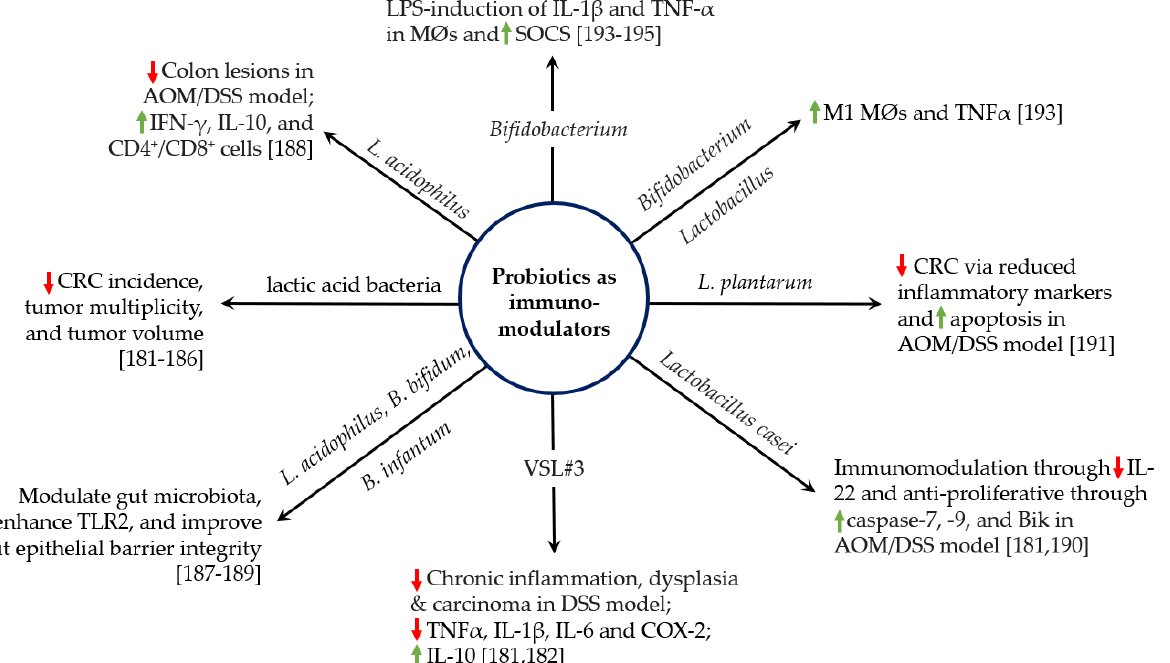
Figure 1. Probiotics as immunomodulators. Probiotics differently affect macrophage responses depending on their activation of varying pathogen-sensing pathways and production of metabolites. Referenced studies use a variety of well-accepted probiotics or mixtures of probiotics to regulate cellular processes such as inflammation, cytokine secretion, and macrophage polarization.